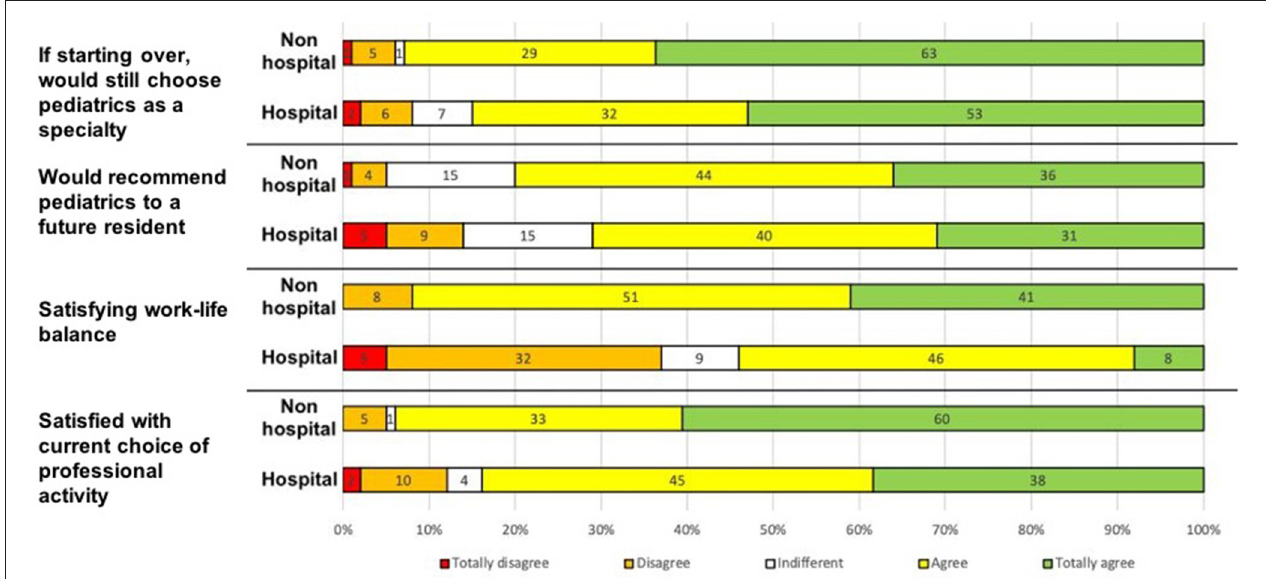
FIGURE 2 | Job satisfaction as a function of the current mode of practice (scored on a Likert scale).